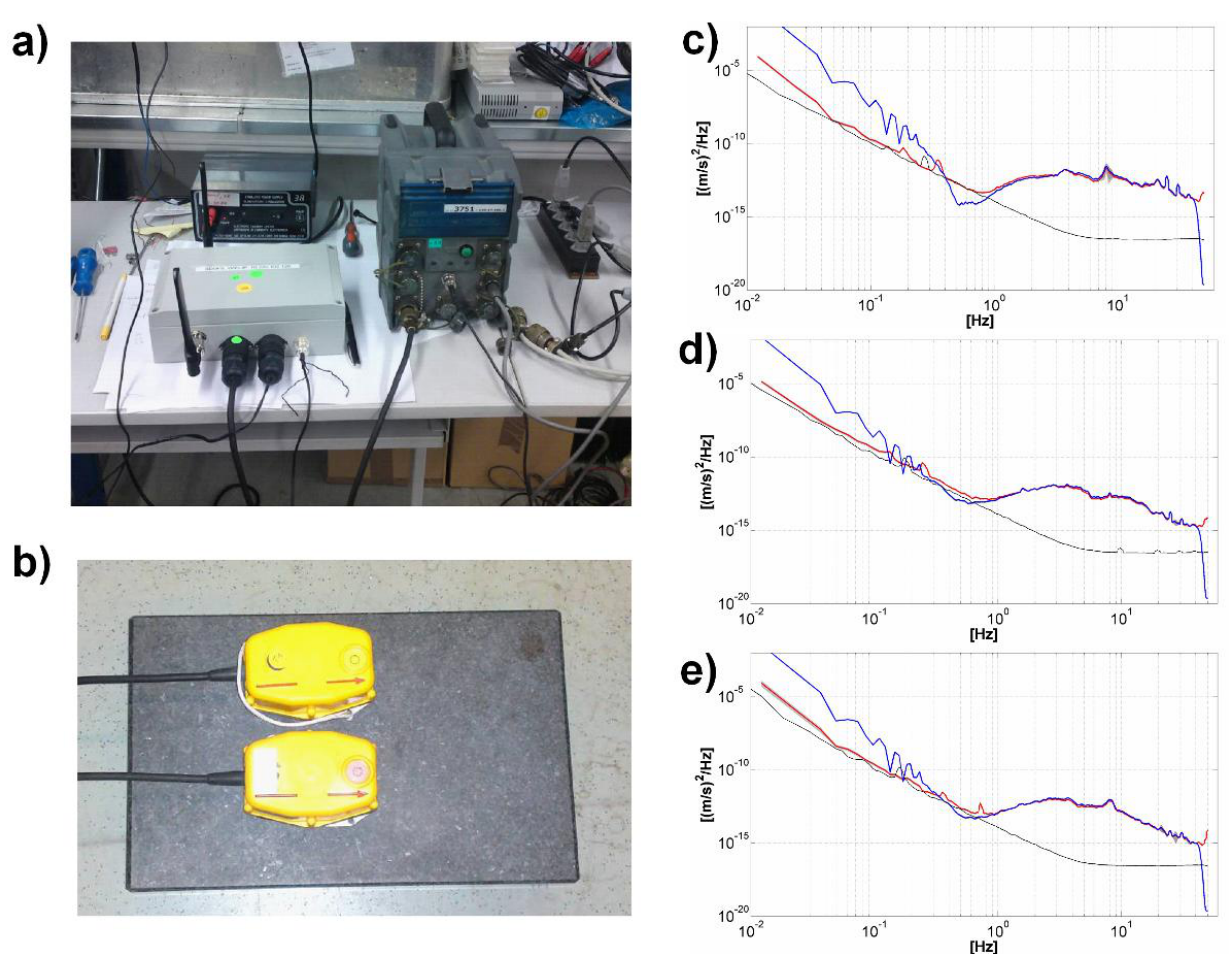
Figure 4. Results from the laboratory experiment. (a) GFZ-WSU and EDL digitizer. (b) 3D SM-PE-6/B 4.5 Hz external geophones deployed over a concrete slab. (c) Spectra from EDL ( blue ), WSU ( red ), WSU‘s self-noise ( black ) for the vertical component of ground motion. (d) same as (c) but for the north-south component. (e) same as (c) but for the east- west